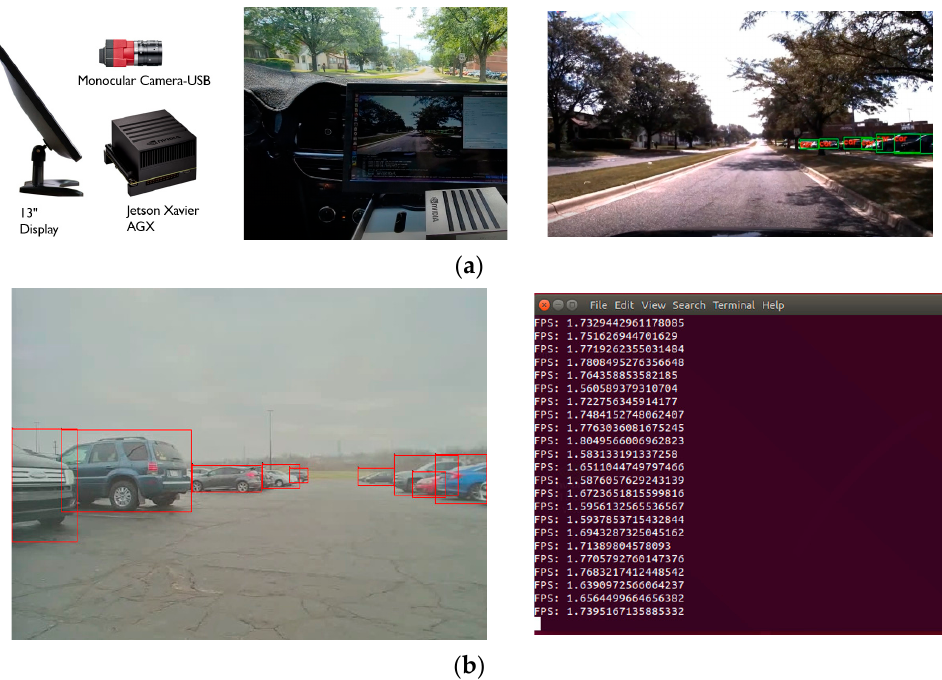
Figure 11. Deployment of the un-optimized transferred DNN model: ( a ) Hardware set-up for real- time inferencing; ( b ) the example output of the un-optimized transferred DNN model on Jetson AGX with fps information.